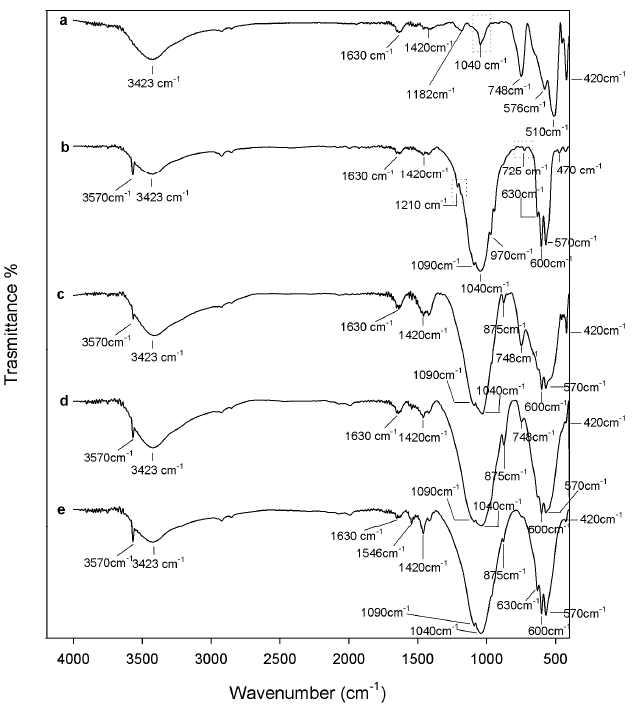
Figure 8. FTIR of ( a ) ZrO 2 ; ( b ) HAp; ( c ) 9ZrO 2 ·1Hap; ( d ) 7ZrO 2 ·3Hap; and ( e ) 5ZrO 2 ·5HAp gels, heated to 1000 °C, after 21 days of exposure to SBF.